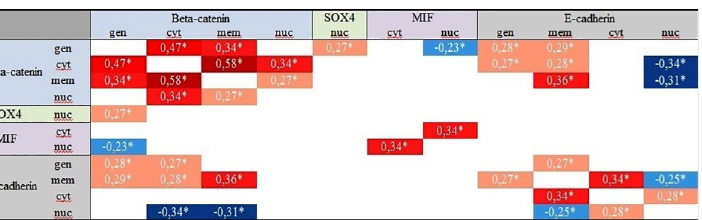
Fig 6. Correlation heat map of proteins expression data measured by immunohistochemistry. Spearman’s rank correlation coefficient was calculated among 110 compilations of protein expression levels. The degrees of correlation are color-coded. The color key designates the correlation was statistically significant. As a statistically significant was considered p-value < 0.05. Red color shades indicate a positive proteins correlation, whereas blue color shades indicate negative proteins correlation. β -catenin, Transcription factor SOX-4, Macrophage migration inhibitory factor and E- cadherin were designated Beta-catenin, SOX-4, MIF, E-cadherin, respectively. Protein correlations are presented taking into account cellular localization. General, cytoplasmic, membrane and nuclear expressions were signed as gen, cyt, mem, nun, respectively.